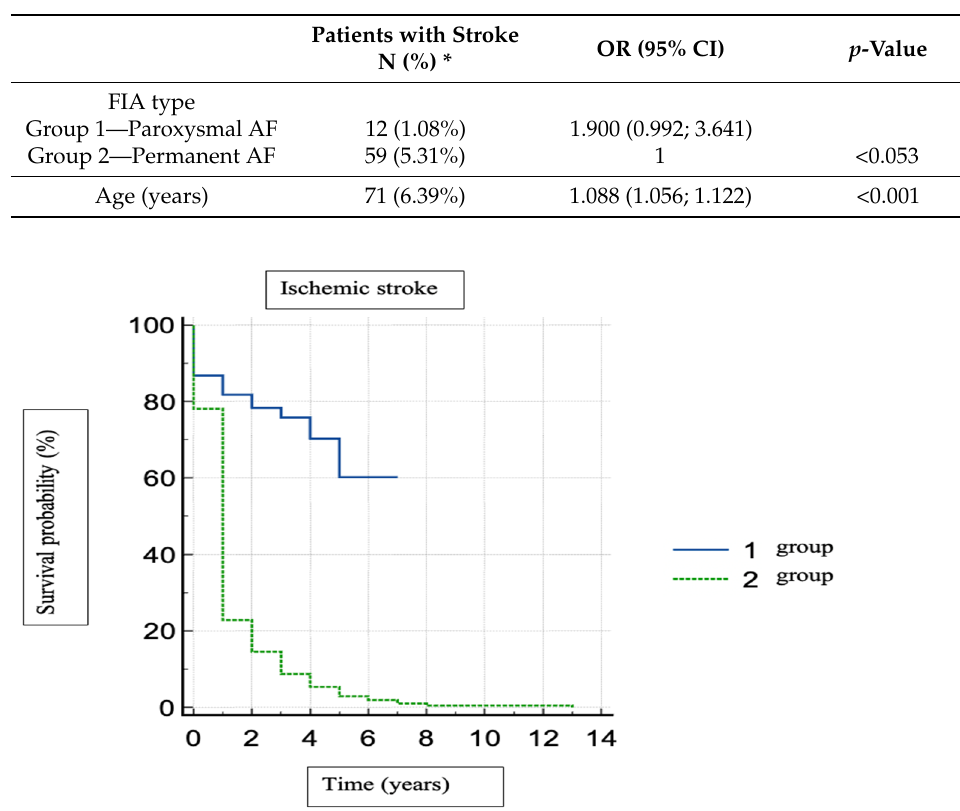
Figure 2. Kaplan–Meier survival probability without stroke. (Group 1 — paroxysmal AF, group 2 — permanent AF).